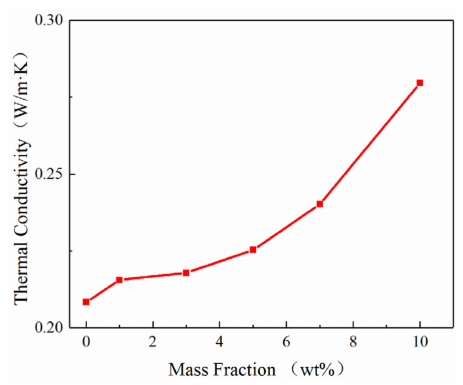
Figure 3. Thermal conductivity of Al 2 O 3 -NWs / epoxy resin composites with di ff erent mass